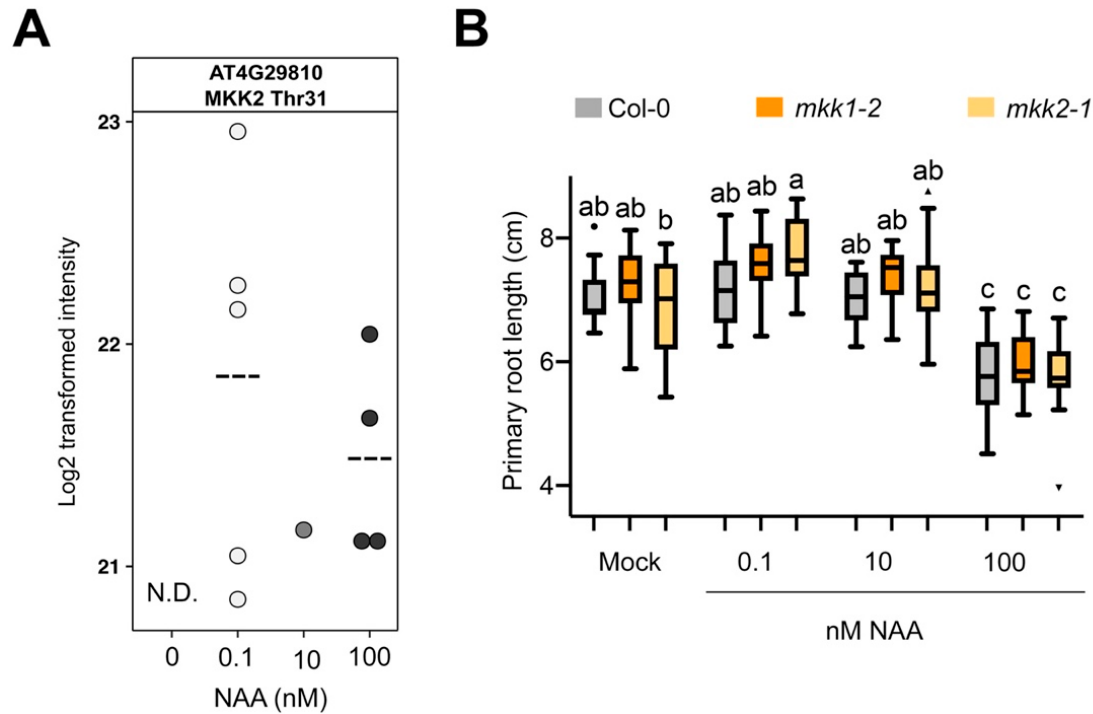
Figure 4. MKK2 and NAA-controlled primary root growth. ( A ) MKK2 phosphoprofile for the FLT(0.001)QS(0.031)GT(0.968)FK phosphopeptide upon NAA treatment. Dashed line indicates mean. Each dot is a biological replicate. N.D., not detected. ( B ) Primary root growth of mkk1-2 and mkk2-1 at different NAA concentrations (n = 10–16 seedlings) at 9 days after germination. Boxplots show average with Tukey-based whiskers and outliers (as dots or triangles). Letters indicate significant difference according to two-way ANOVA with Tukey post-hoc test ( p < 0.05).